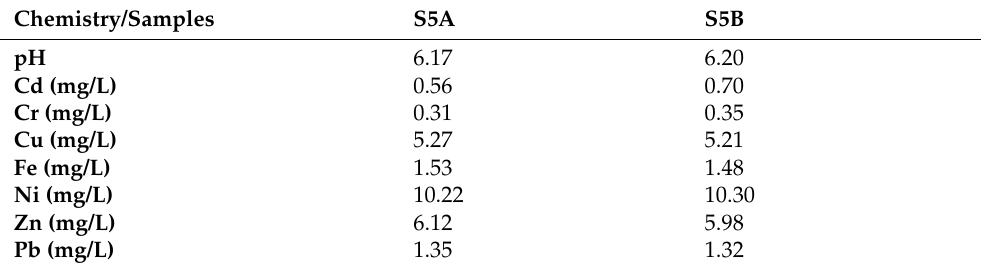
Table 3. Chemical analysis results of the tested e-wastes.